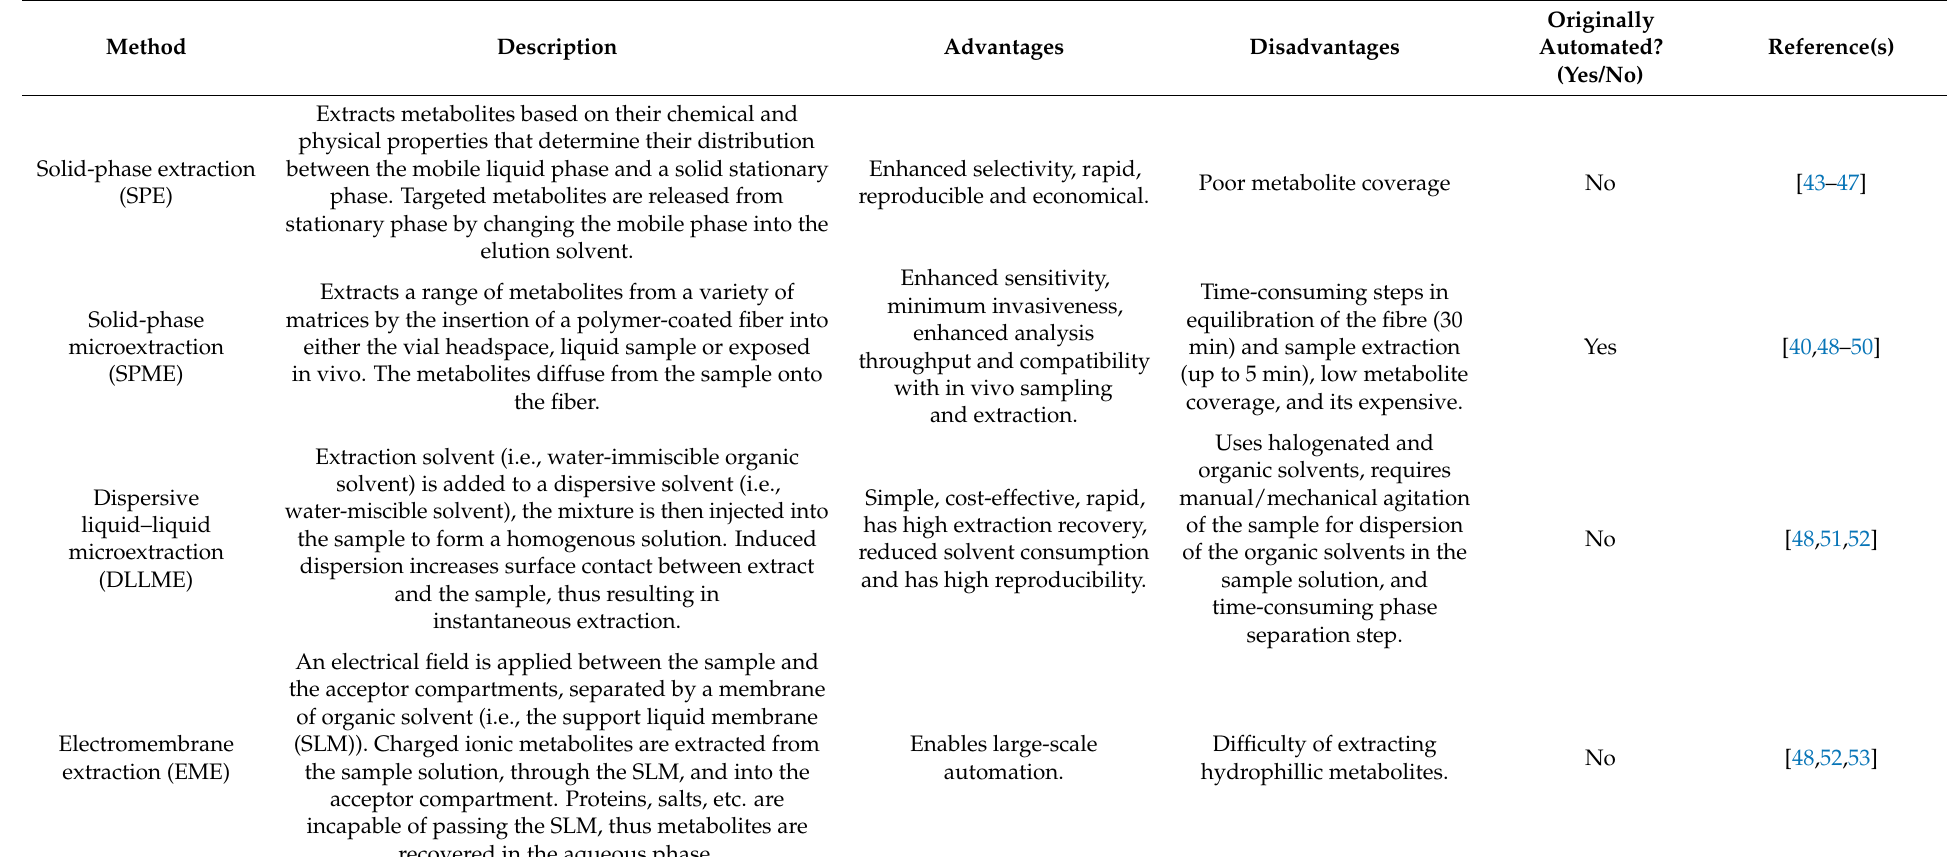
Table 1. Automated sample preparation methods with their advantages and disadvantages over traditional sample preparation